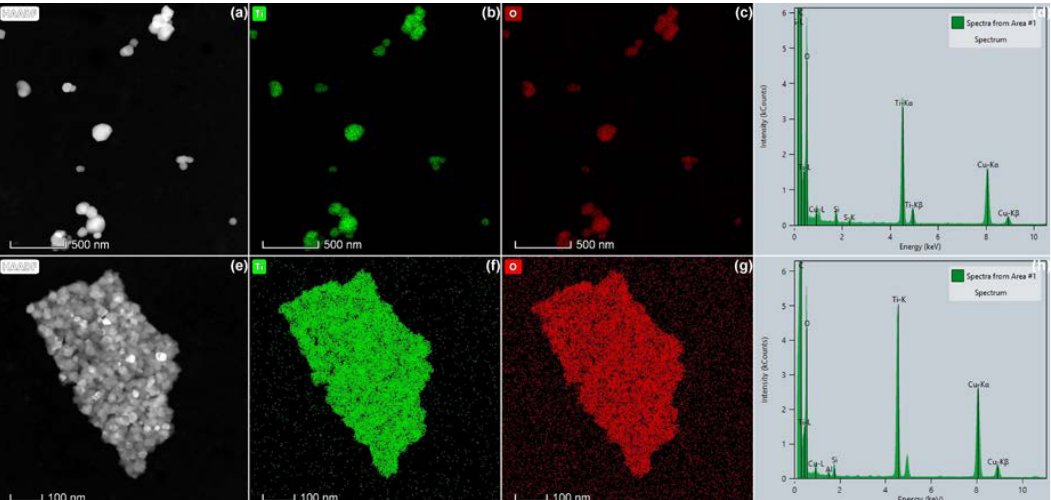
Figure 3. High-angle annular dark field (HAADF)–scanning transmission electron microscopy (STEM) images ( a , e ), spectral images of Ti ( b , f ) and O ( c , g ) obtained by energy-dispersive X-ray spectroscopy (EDX), and EDX spectra ( d , h ) of E171 materials purchased at webshops: (a–d) anatase TiO 2 (E171-06) and (e–h) pearlescent pigment (E171-05). Nanomaterials 2020 , 10 , x FOR PEER REVIEW